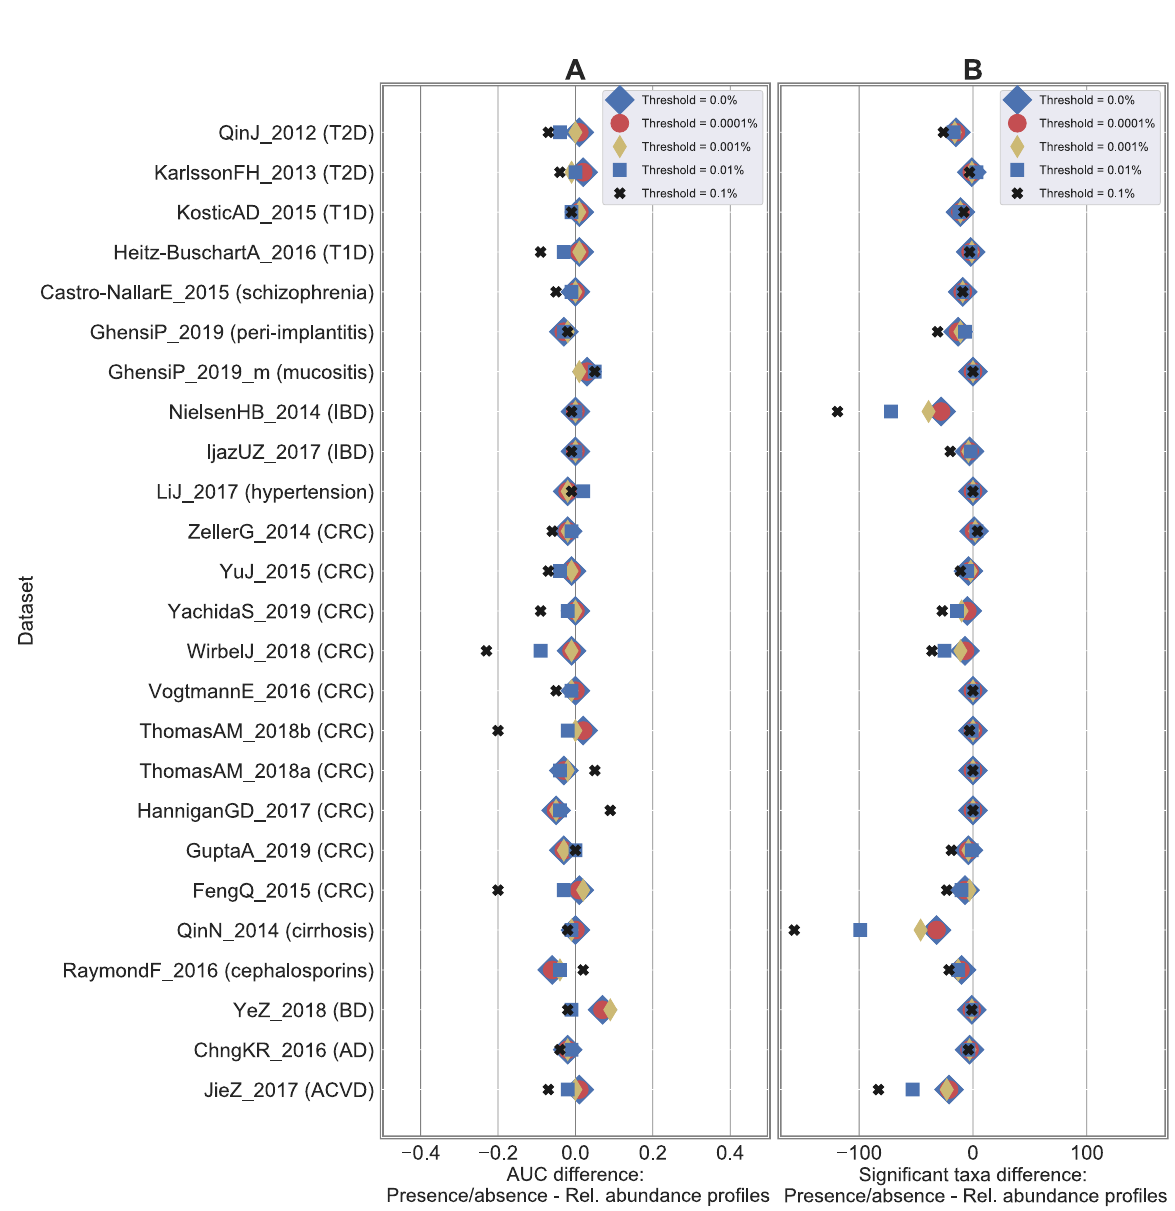
Fig 3. Classification accuracies are not impacted when relative abundances are thresholded up to 0.001%. Results on the 25 case-control shotgun studies by comparing the baseline (i.e., species-level relative abundance profiles) with the presence/absence profiles generated by thresholding at different relative abundance values (ranging from 0% to 0.1%). (A) Difference in AUC between the presence/absence and the relative abundance RF classification result. A positive value indicates that presence/absence outperforms relative abundance data. AUC scores at different thresholds are summarized in S2 Table. (B) Difference in number of statistically significant taxa (numbers summarized in S7 Table).